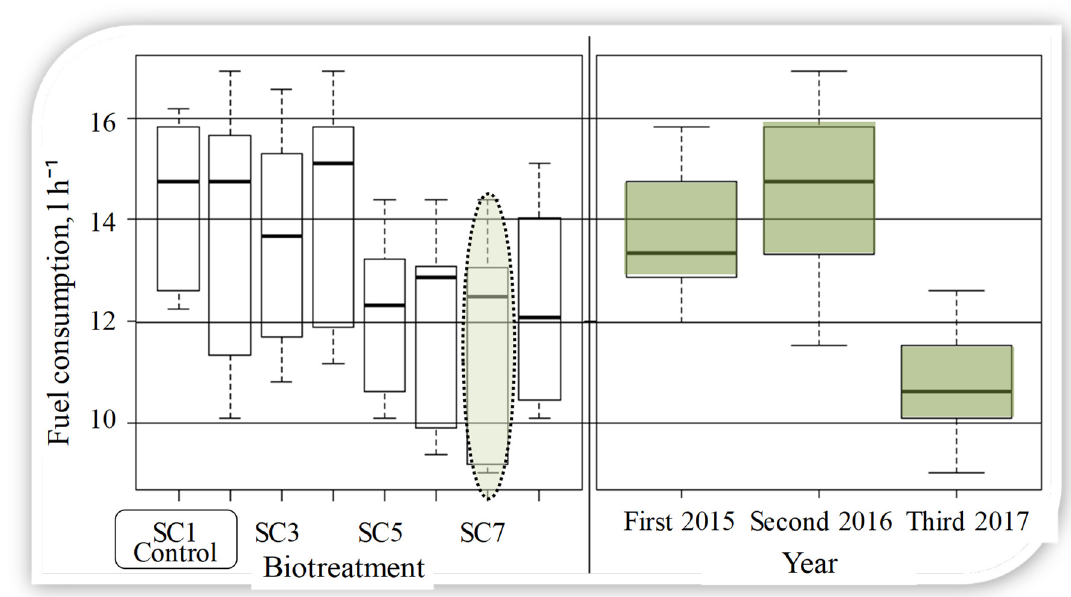
Figure 4. Disc harrowing fuel consumption (L h − 1 ) dependence on bio-impact(s) time (year) and scenario.